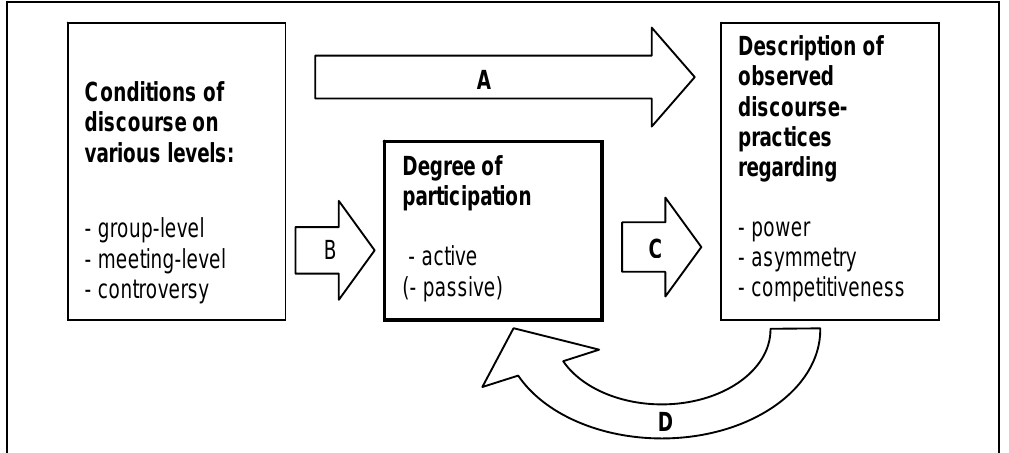
Figure 1 : Participation as a variable in the research design for Studying Practices of Discourse as a Dependent